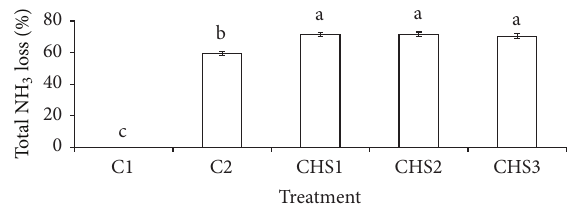
Figure2:Totalammonialossfordifferenttreatments(C1:soilalone,